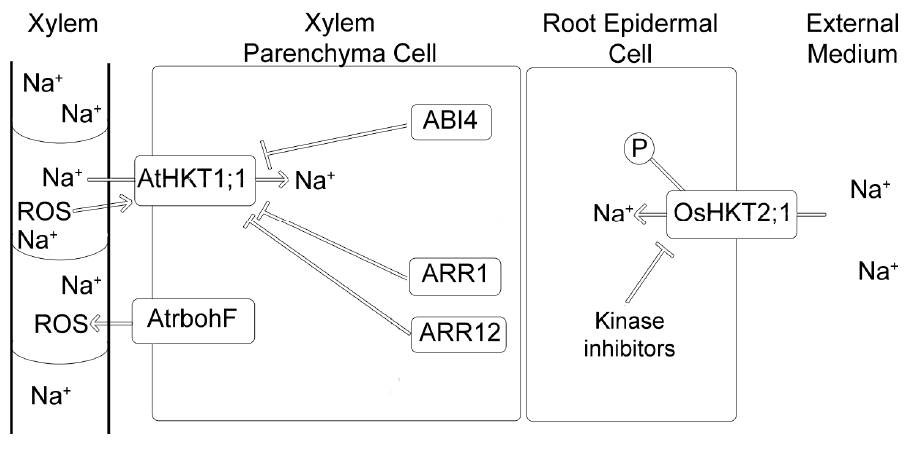
Figure 1. Mechanisms involved in the regulation of HKT transporters. Cytokinins and ABI4 down regulate the expression of AtHKT1;1 whereas the presence of ROS in the xylem stream affects expression or activity of AtHKT1;1 . In rice, the application of phosphorylation inhibitors causes a severe reduction in Na + influx in the root epidermal